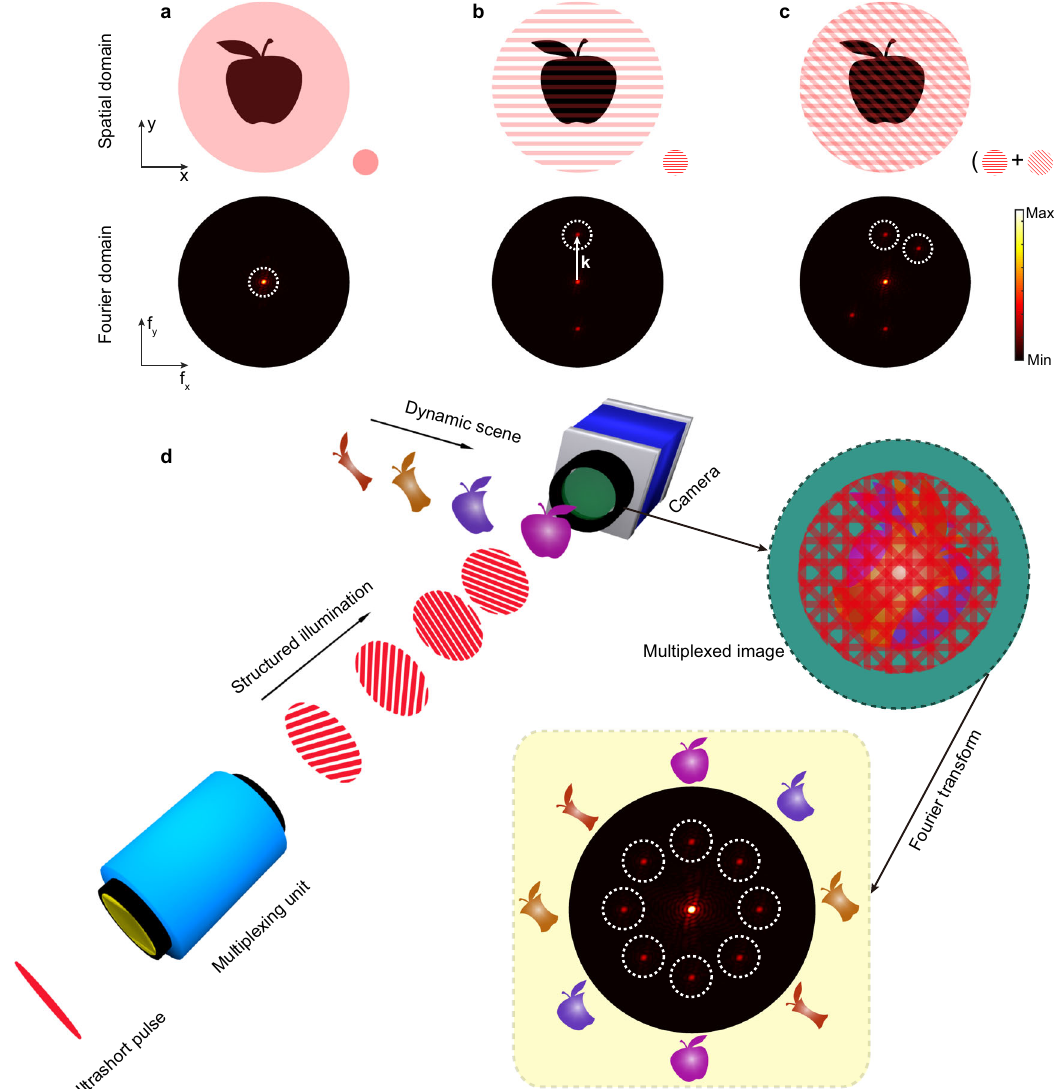
Fig. 1 | Concept of probe-beam multiplexing in the spatial-frequency and time domains. a An object (here, an apple) is uniformly illuminated in real space. The frequency content of the resulting image is band-limited and is mainly localized in thecentralregionofFourierspace. b Illuminatingthesameobjectwithasinusoidal intensitymodulationproducestwo ‘ image copies ’ ofthe object in two unexploited regions, symmetrically located in Fourier space with respect to the origin. Their actual locations (i.e. the distance from the origin) depend on the spatial-frequency